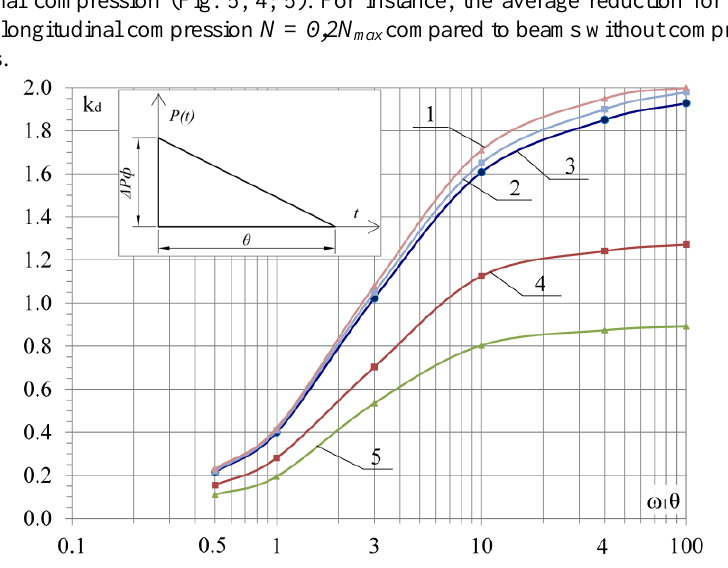
Fig. 5. Diagram for dynamic amplification factor for beams in conventional elastic stage (limit state 1 а ) on rigid supports depending on the level of longitudinal compression and ω 1 θ parameter; 1 – B.S. Rastorguev, A.I. Plotnikov, D.Z. Khusnutdinov [15] (no longitudinal compression); 2 – A.S. Abdul- Rakhman [13] (no longitudinal compression); 3, 4, 5 – the authors’ research outcomes, 3 – beams without compression, 4 – structures subjected to longitudinal compression N = 0,2N max , 5 – beams subjected to longitudinal compression N = 0,4N